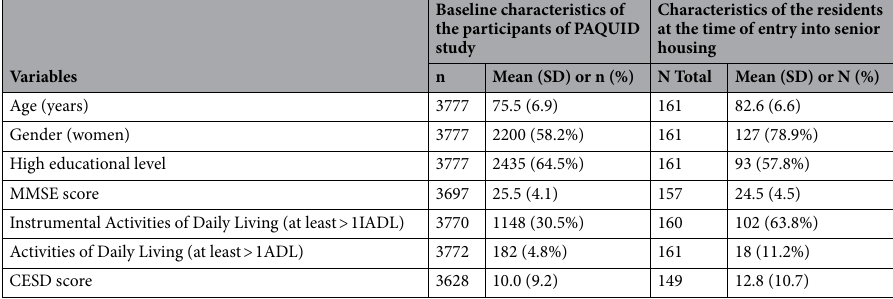
Table 4. Baseline characteristics of participants of PAQUID study and characteristics of the residents at the time of entry into senior housing.